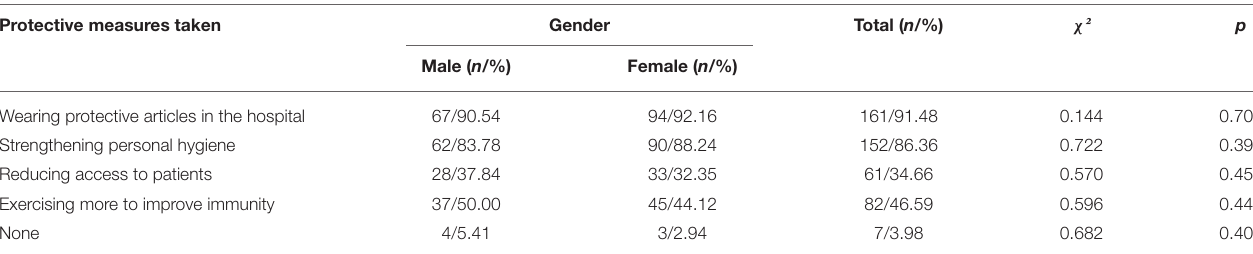
TABLE 5 | Comparison of differences in the prevention and control measures taken by gender. Protective measures taken Gender